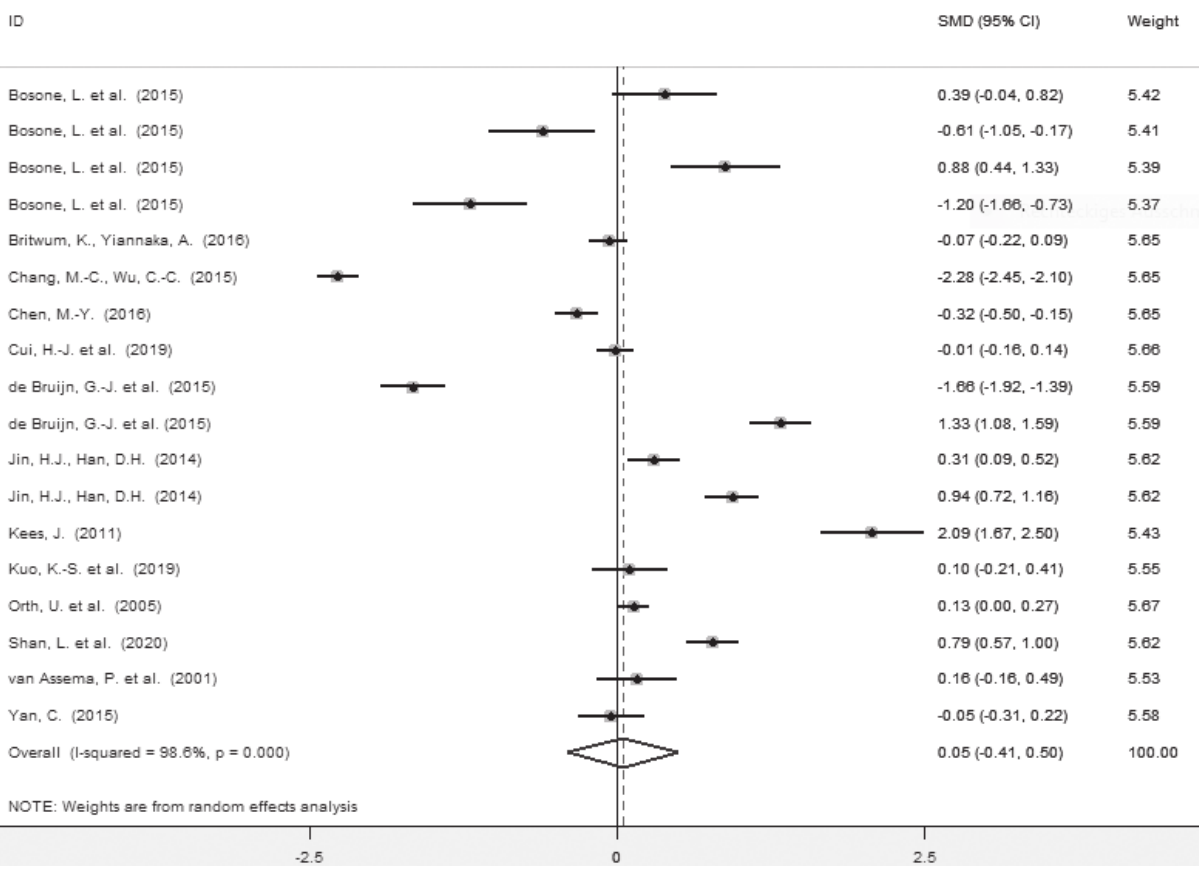
Figure 5. Sub-group meta-analysis results for